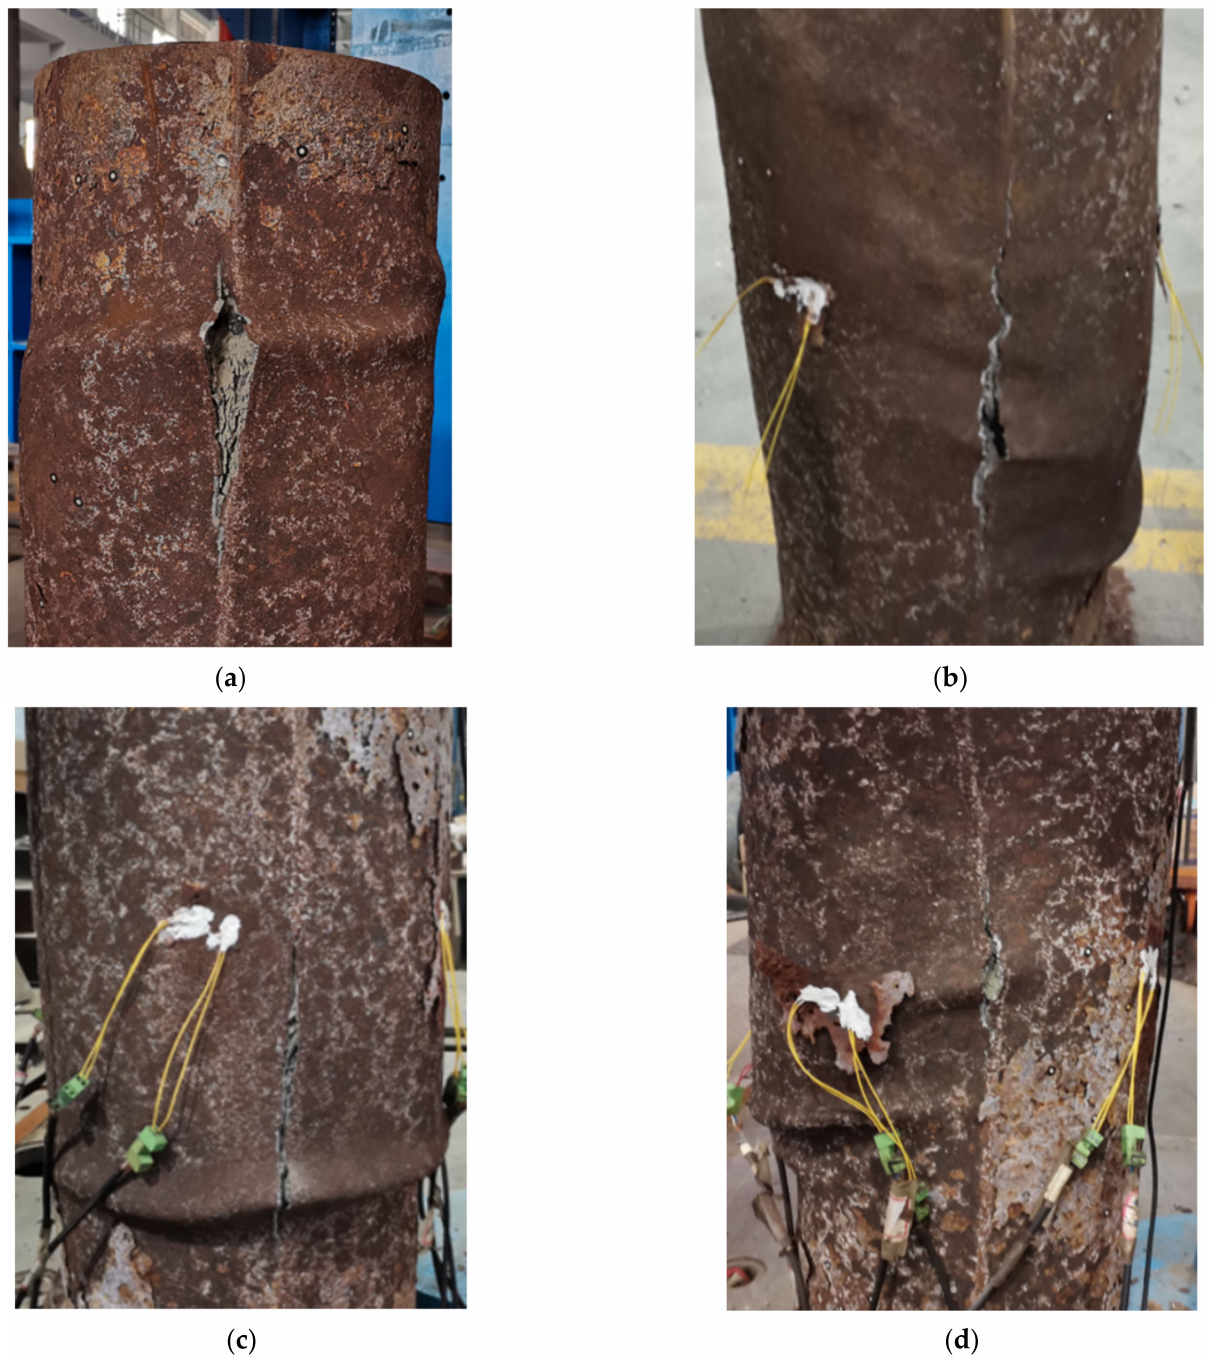
Figure 10. Cracks in corroded CFST specimens with welded steel tubes: ( a ) AT1100C50A; ( b ) AT1100C50B; ( c ) AT1100C50E; ( d )